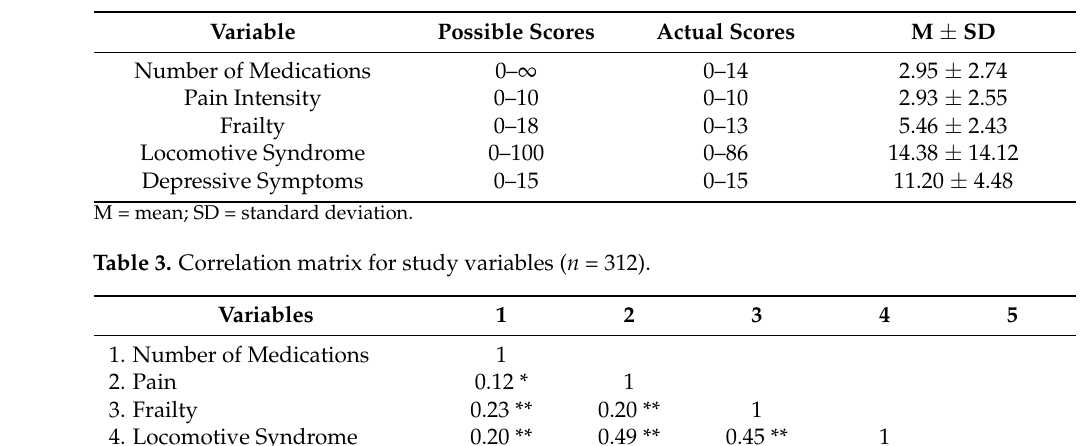
Table 2. Descriptive analysis of the study variables ( n = 312).